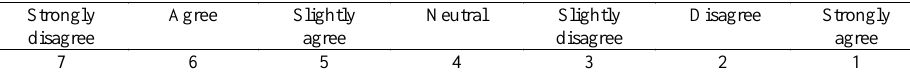
Table 2: Coding questions based on 7 options of Likert scale